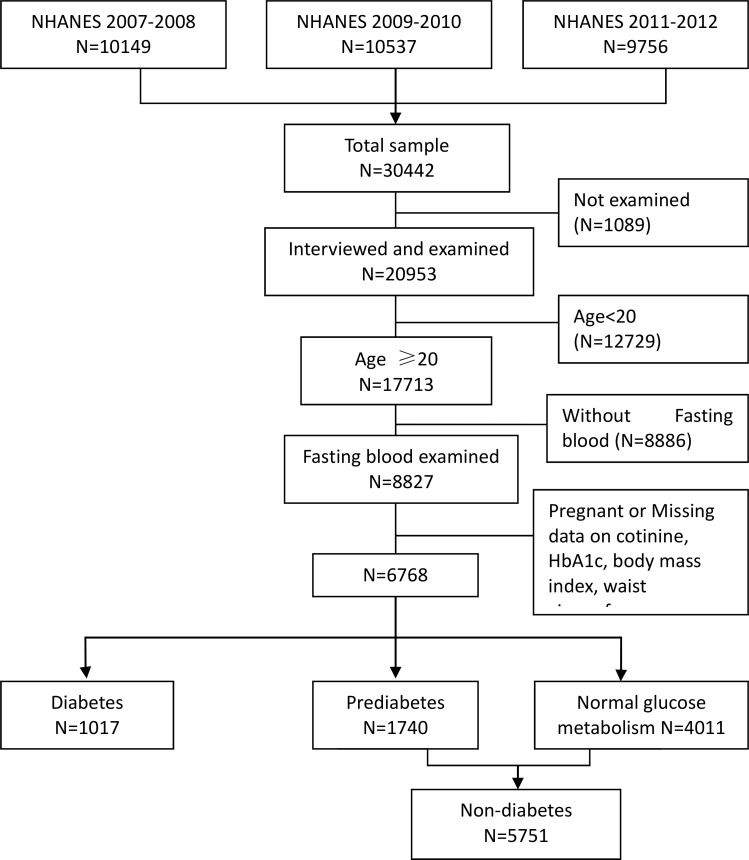
Flowchart depicting three successive waves (2007–2012) of continuous NHANES used for analysis.